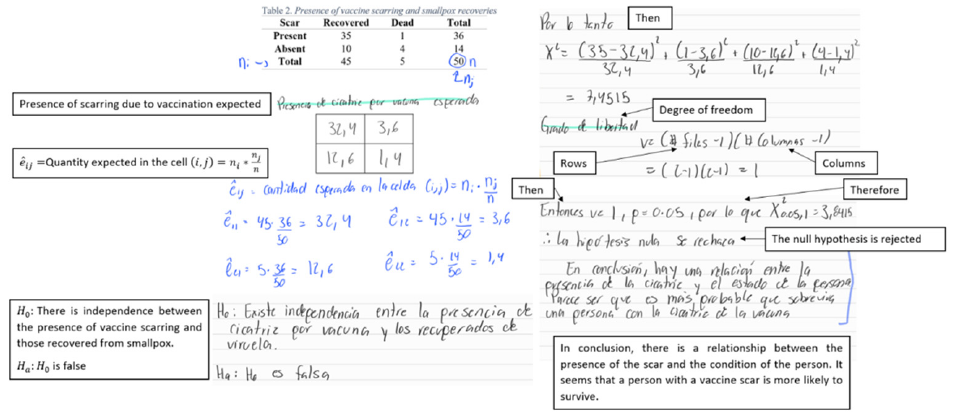
Figure 9. The practice of the prospective Teacher 17 (G2) on Activity 2.